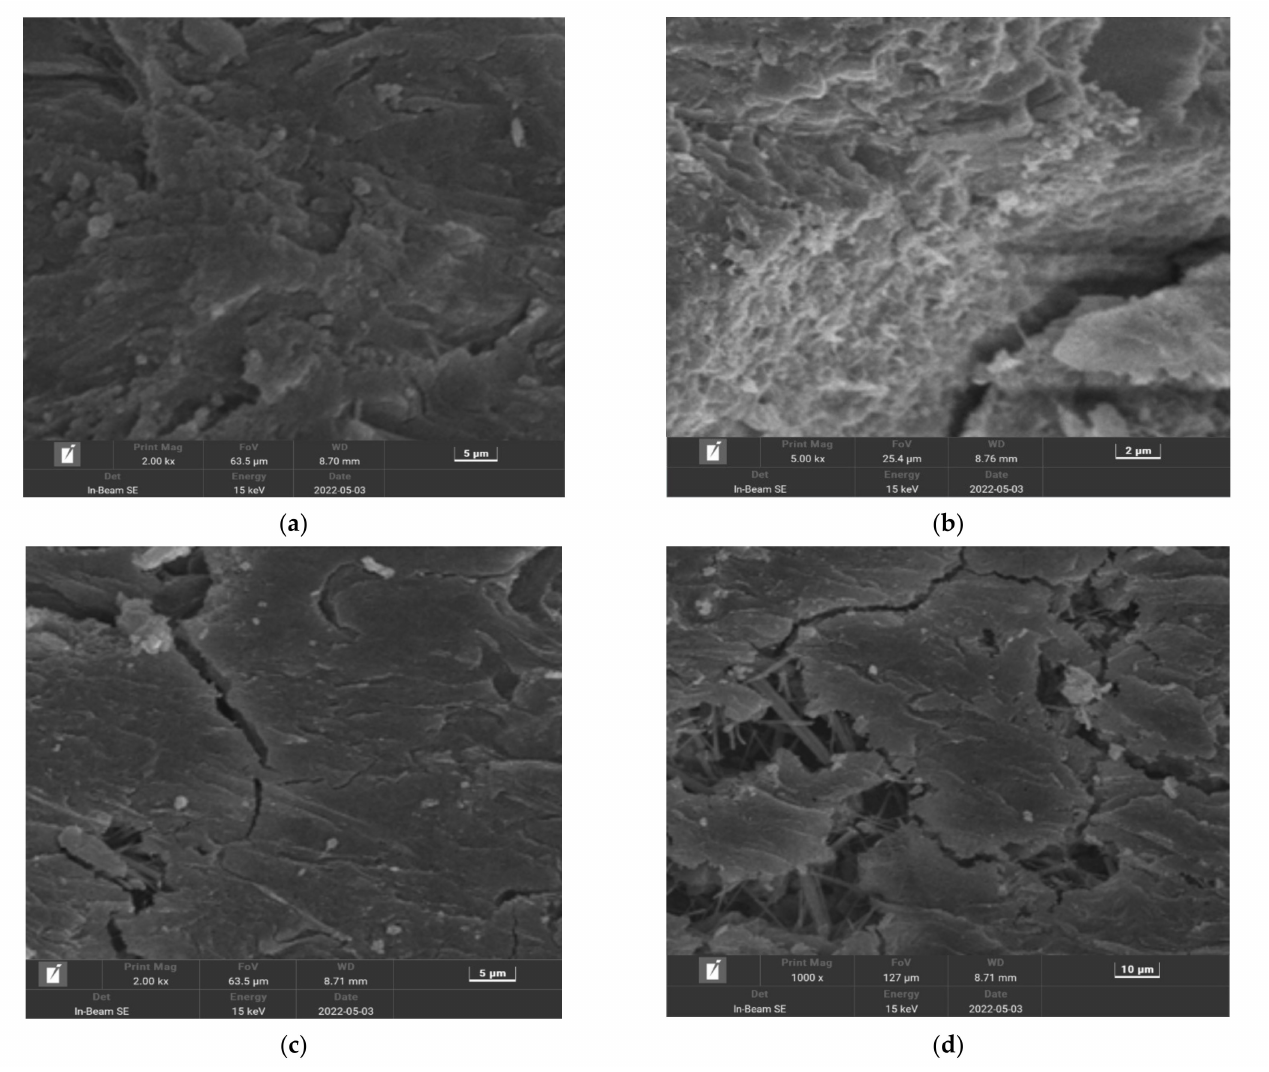
Figure 12. PFMSC microtopography of PFMSC before and after freeze–thawing: ( a ) PFMSC0–0: Before freezing and thawing, ( b ) PFMSC0–0: After freezing and thawing, ( c ) PFMSC1.0–9: Before freezing and thawing, ( d ) PFMSC1.0–9: After freezing and